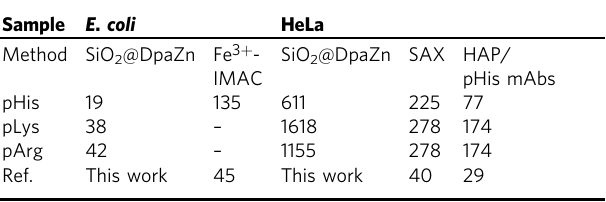
Table 2 The number of N-pho identi fi ed from E. coli and HeLa lysates by our and other